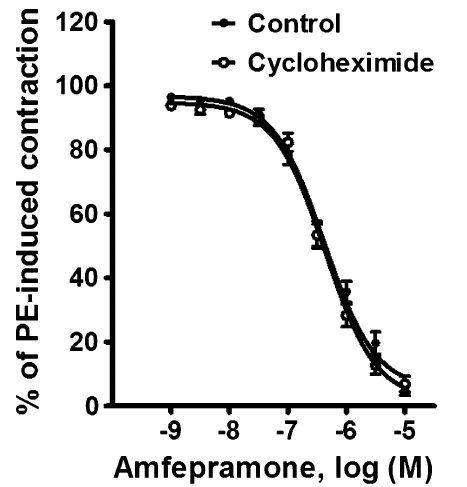
Figure 6. Effects of 10 –5 M cycloheximide on amfepramone- induced vasorelaxation in rat aortic rings with functional endothe- lium and precontracted with 10 –6 M phenylephrine (PE). Data are reported as means±SE of n=6 observations. P . 0.05 vs control (two-way repeated-measures